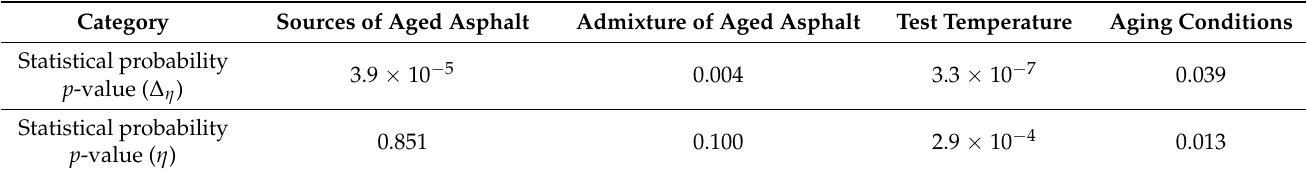
Table 4. Usually, the significance level α = 0.05. Table 4. Analysis of variance results for reclaimed asphalt with Δ η and η . Table 4. Analysis of variance results for reclaimed asphalt with ∆ η and η .